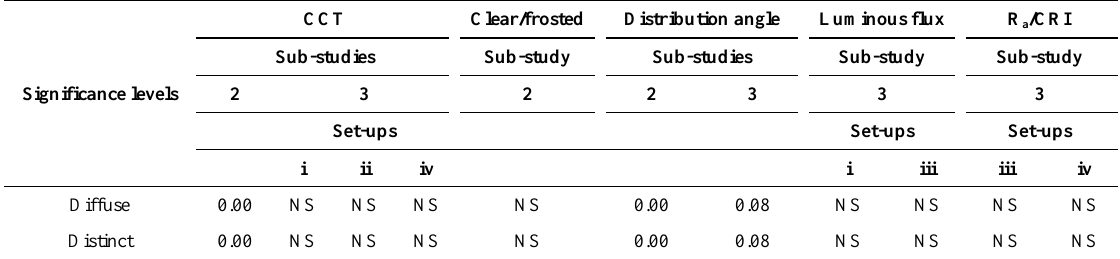
Table 6. Significance levels for regressions of the effect of product properties on assessed concepts of diffuse and distinct light, results from tests performed in sub-studies 2 and 3. A value of 0 or close to 0 indicates a significant effect, while NS indicates no significant effect ( p >